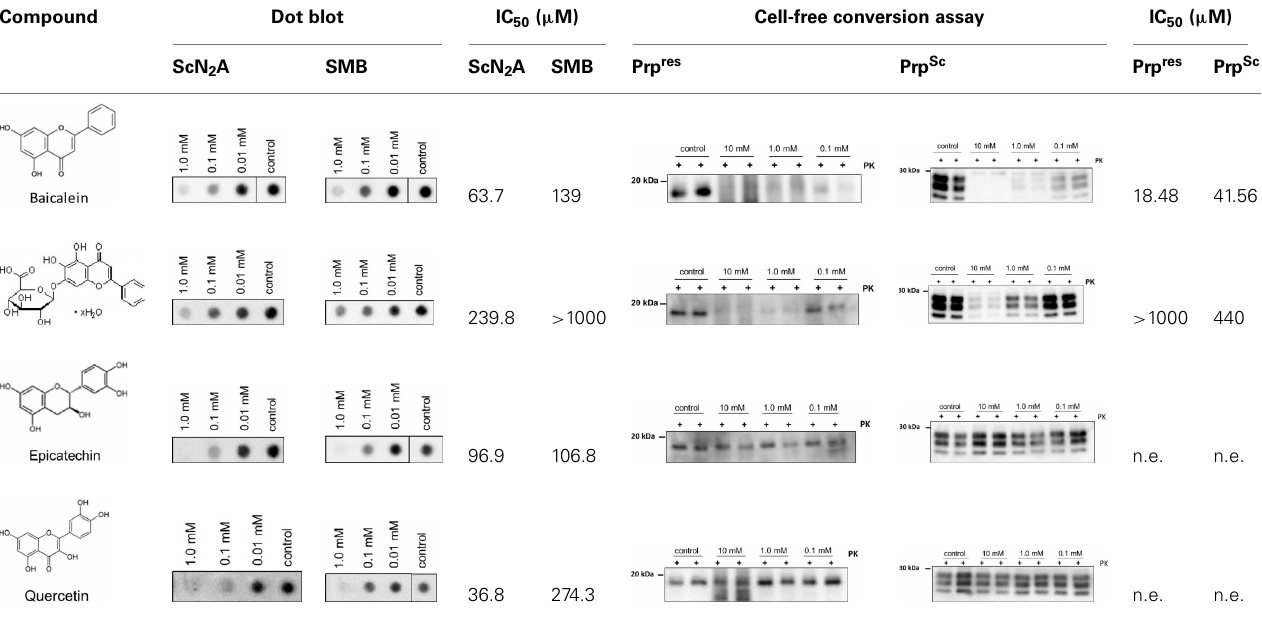
Table 1 | Chemical structures of flavonoids and in vitro analyses.